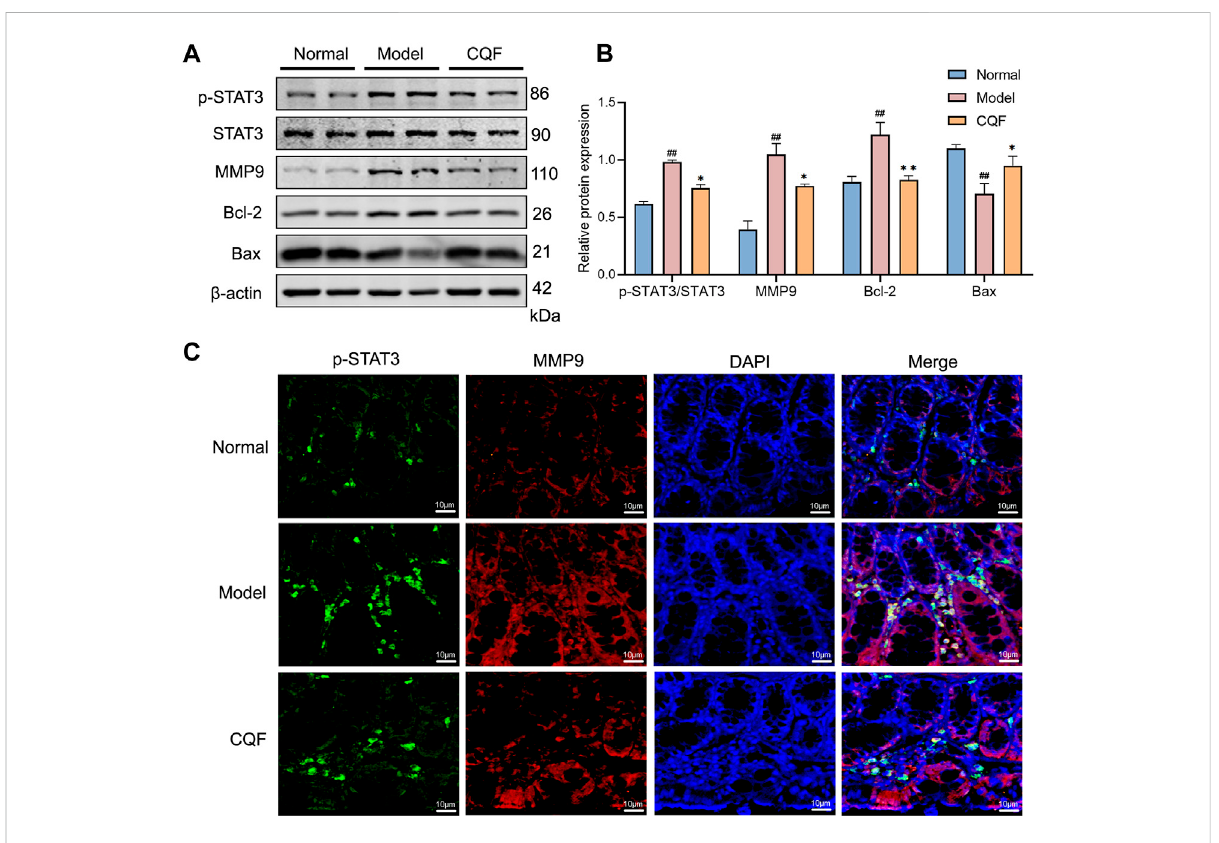
FIGURE 7 CQF suppressed the phosphorylation of STAT3 and altered the expression of its downstream proteins. (A,B) Expression of MMP9, p-STAT3, STAT3,Bcl-2,andBaxproteins incolontissue(n =4per group). (C) Immuno fl uorescencestainingofcolon tissue,green: p-STAT3, red:MMP9,blue: DAPI. Values are expressed as mean ± SEM. # p < 0.05, ## p < 0.01, compared with normal mice; *p < 0.05, **p < 0.01, compared with AOM/DSS- treated